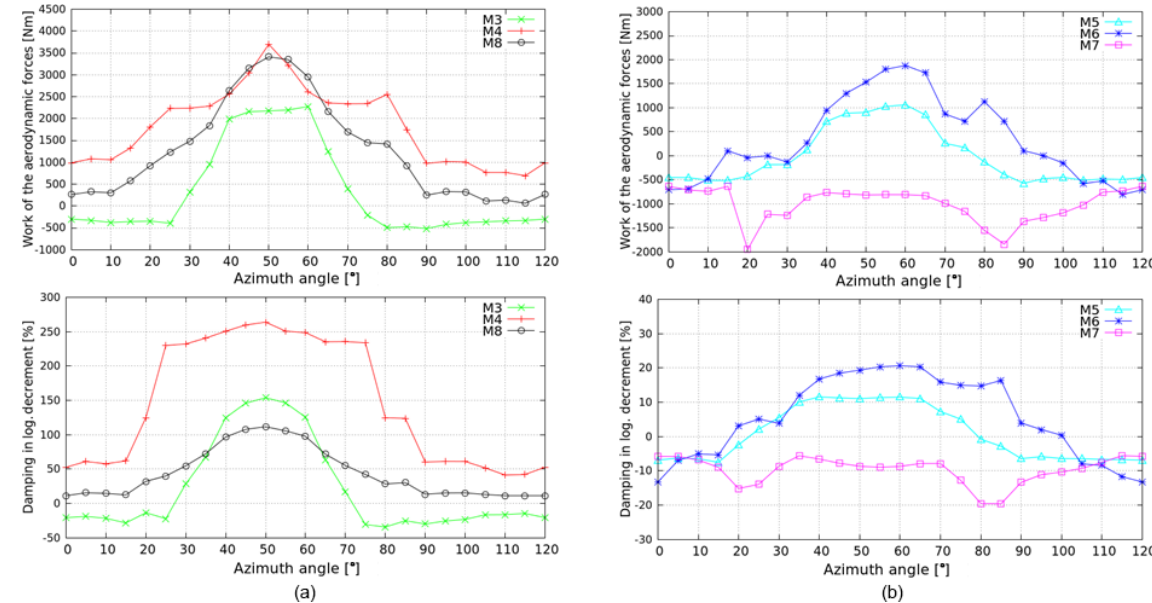
Figure 25. Comparison between aerodynamic work (0.2m modal amplitude) and damping results versus azimuth angle for steady-state aerodynamics; U = 42 . 5ms − 1 and yaw = 30 ◦ . (a) In-plane (flapwise) modes and (b) out-of-plane (edgewise